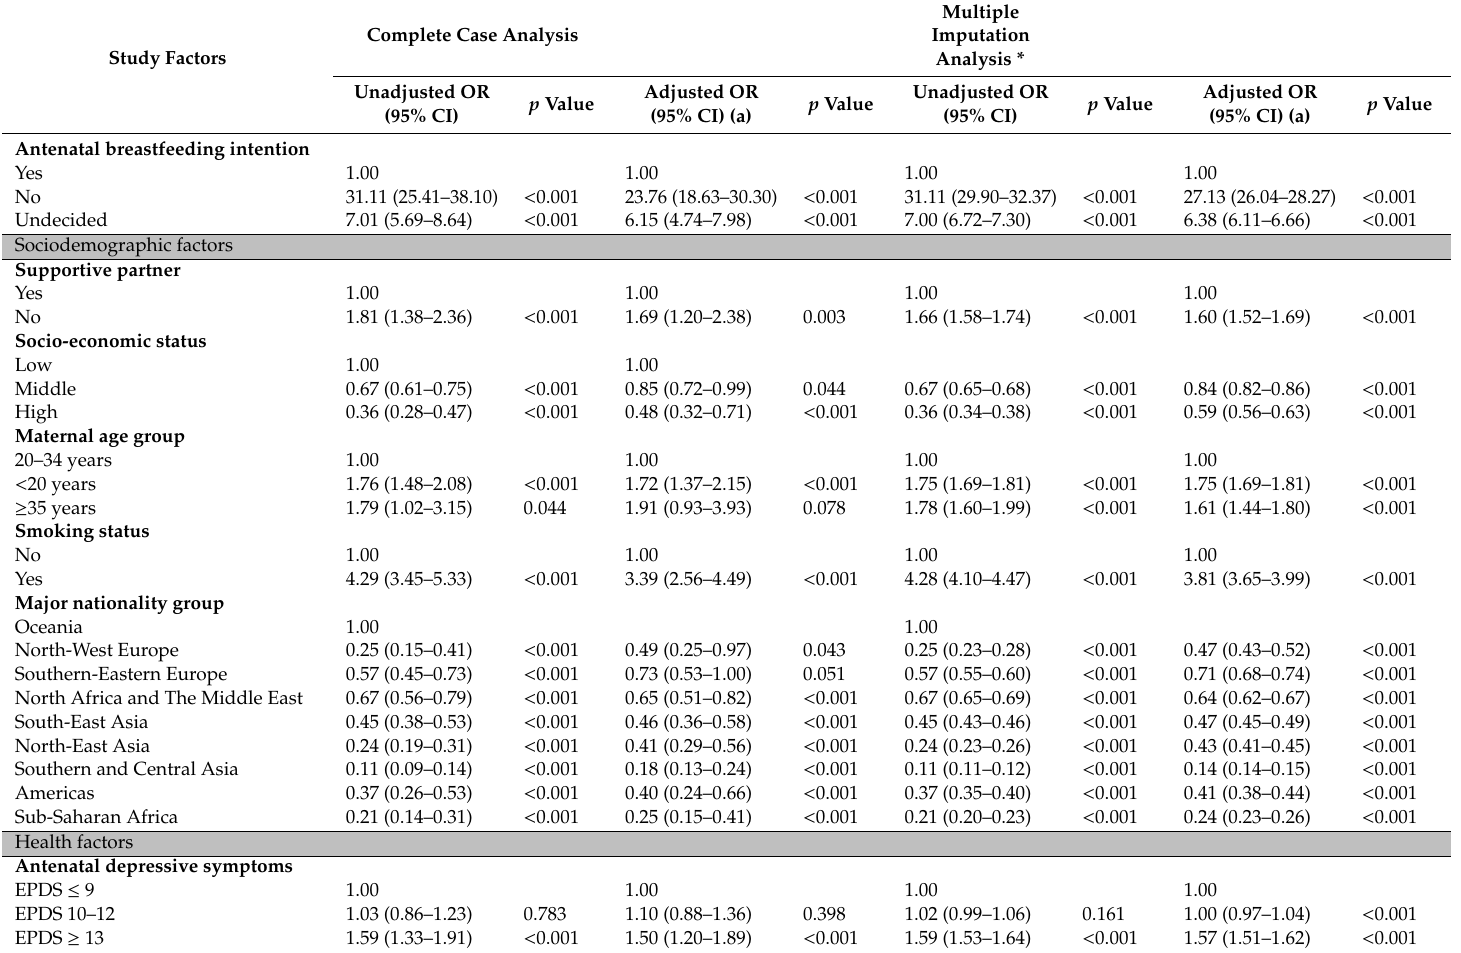
Table 3. Determinants of exclusive breastfeeding cessation in the early postnatal period among CALD mothers in South Western Sydney and Sydney Local Health Districts, 2014–2016 ( N =